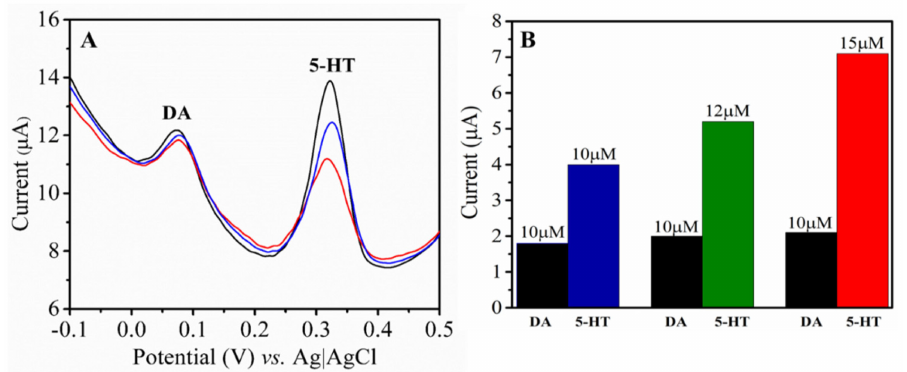
Figure 7. ( A ) DPVs recorded at the NH-HNP-Chit/SPCE in 5-HT at different concentrations (10, 12 and 15 µ M) and in the presence of DA (10 µ M). ( B ) Bar representation of the NH-HNP-Chit/SPCE response for different concentrations of 5-HT in the presence of DA (10 µ